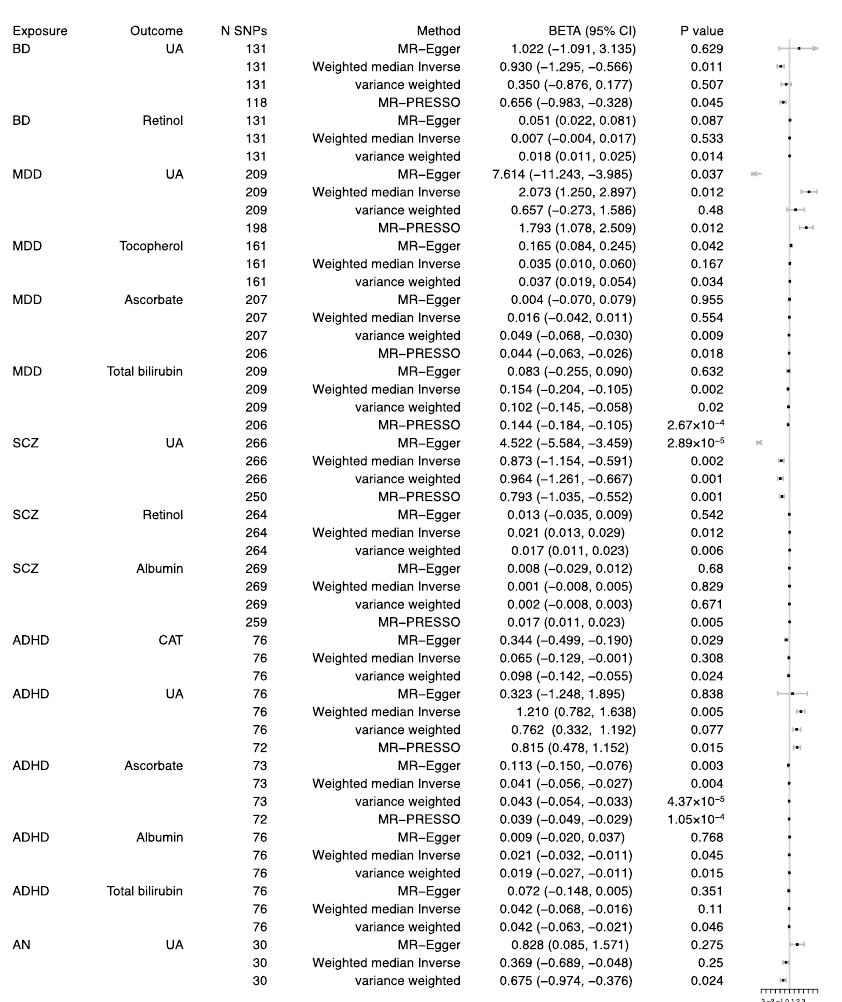
Figure 2. Associations between genetically predicted oxidative stress injury biomarkers and the risk of psychiatric disorders. CAT, catalase; UA, uric acid; BD, bipolar disorder; ADHD, attention-deficit/hyperactivity disorder; ASD, autism spectrum disorder; AN, anorexia nervosa; SNP, single nucleotide polymorphism.